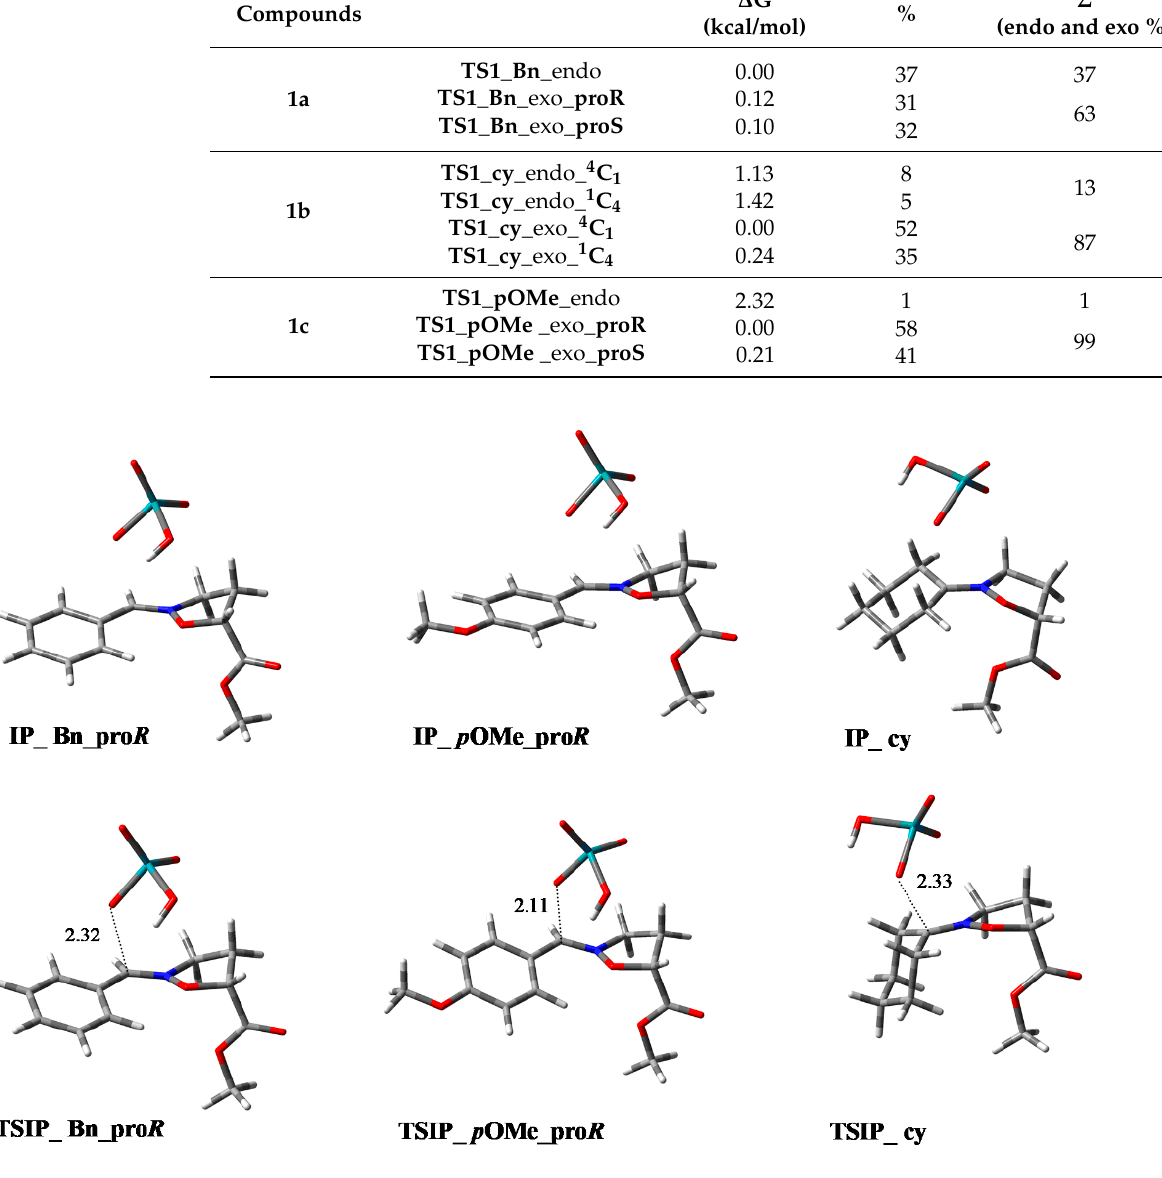
Figure 3. Three-dimensional plots of representative conformations of ion pairs ( IP ) and the corresponding transition states ( TSIP ) leading to P1 for compounds 1a–c . For TSs imaginary frequencies are shown as dotted lines and distances are reported in angstroms.